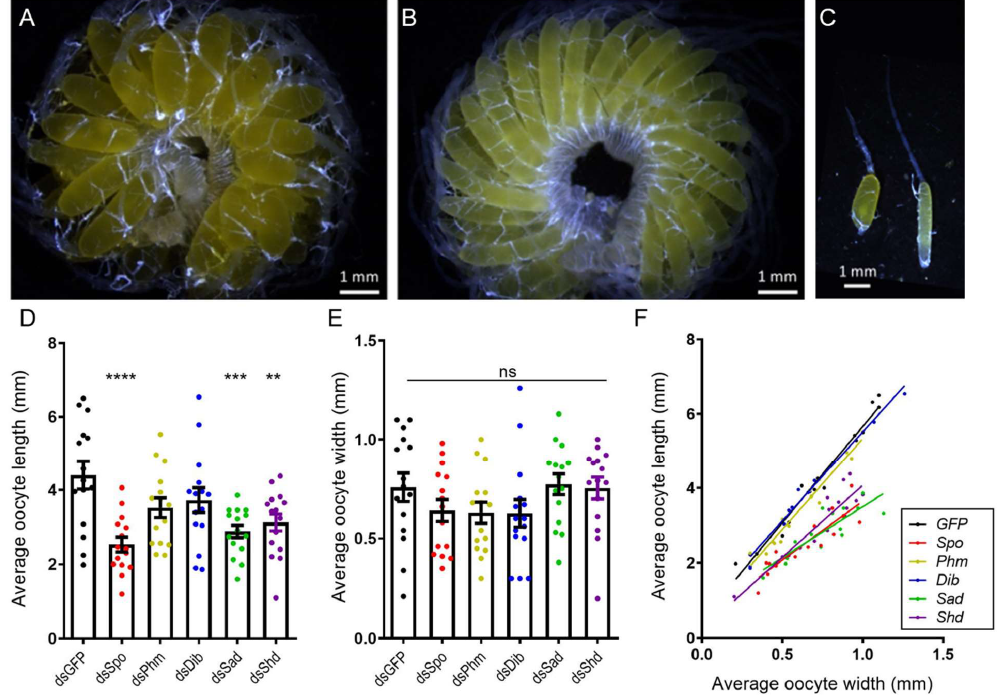
Figure 2. Oocyte development in dsRNA-injected adult females twelve days after the final molt. For each female locust, the width and length of five individual basal oocytes were measured twelve days after the final molt (AdD12). ( A ) Representative ovary for the observed phenotype upon RNAi-mediated knockdown of SchgrSpo , SchgrSad or SchgrShd (average size of basal oocytes: length = 2.84 ± 0.12 mm, width = 0.72 ± 0.03 mm). ( B ) Ovary representative for locusts in which GFP , SchgrPhm and SchgrDib were targeted (average size of basal oocytes: length = 3.88 ± 0.19 mm, width = 0.67 ± 0.04 mm). ( C ) Representative ovariole for the observed phenotype upon RNAi-mediated knockdown of SchgrSpo , SchgrSad or SchgrShd (left, basal oocyte: length = 2.4 mm, width = 0.9 mm) and the control (right, basal oocyte: length = 3.5 mm, width = 0.6 mm). Scale bars A-C = 1 mm. ( D , E ) The average length ( D ) or width ( E ) of five basal oocytes per locust and per condition, represented as mean ± S.E.M.; each dot represents one data point ( n = 15). Significant differences are indicated by (an) asterisk(s) (**** p < 0.0001; *** p < 0.001 and ** p < 0.01; ns = ‘not significant’; One-way ANOVA with Dunnett’s Multiple Comparisons Test). ( F ) The data represent the average length (Y-axis) and width (X-axis) of five basal oocytes collected from each individual female treated with dsSpo , dsPhm , dsDib , dsSad , dsShd or dsGFP (coloured dots), as well as the linear regression (coloured lines) ( n = 15 per condition). The Pearson‘s correlation coefficients for the dsSpo , dsPhm , dsDib , dsSad , dsShd or dsGFP knockdown conditions are 0.8954, 0.9771, 0.9888, 0.8587, 0.9205 and 0.9840, respectively ( p < 0.0001 in all conditions). The linear regression curves of dsSpo -, dsSad - and dsShd - treated females are significantly different from the control condition ( p = 0.00029 for dsSpo -treated females and p < 0.0001 for dsSad - and dsShd -treated females; ANCOVA).